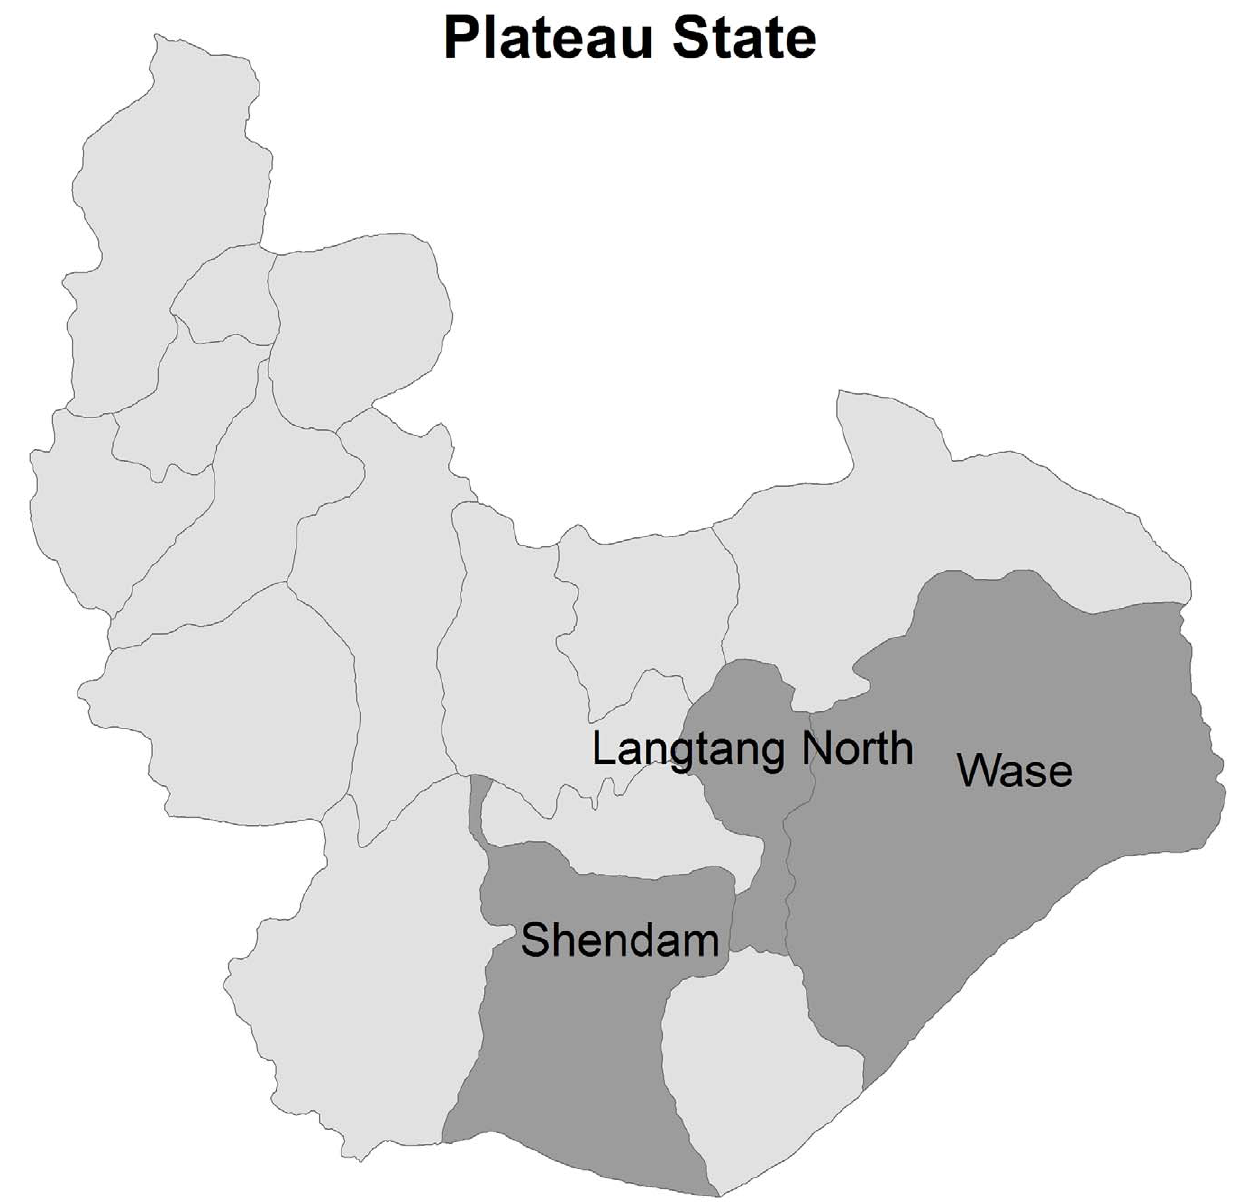
Figure 2. Map of Local Government Areas (LGAs) surveyed.